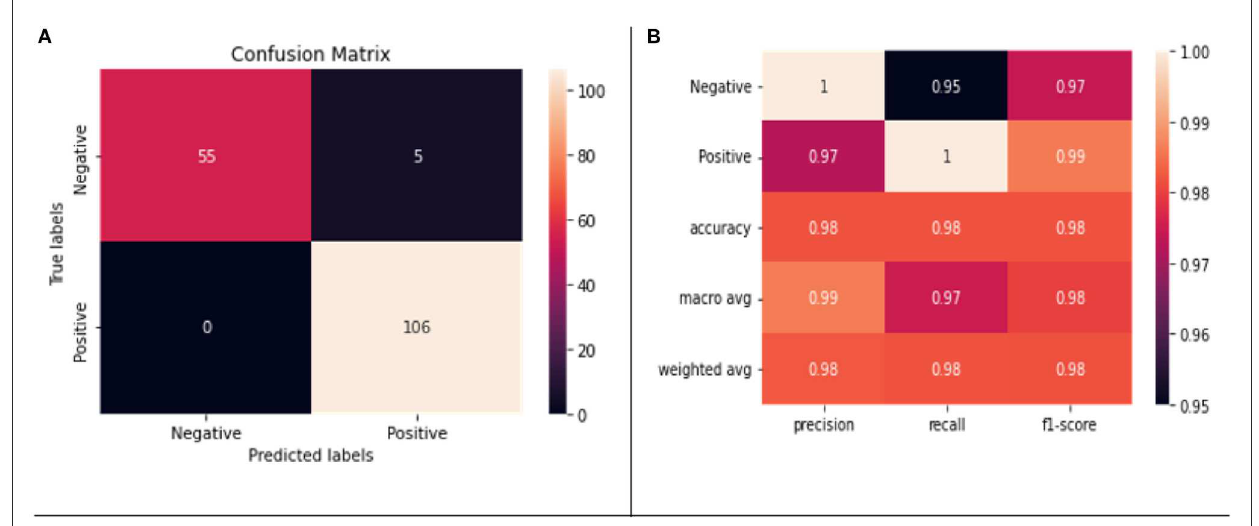
FIGURE5 (A) Confusion matrix for the testing data. (B) Classification report on the testing